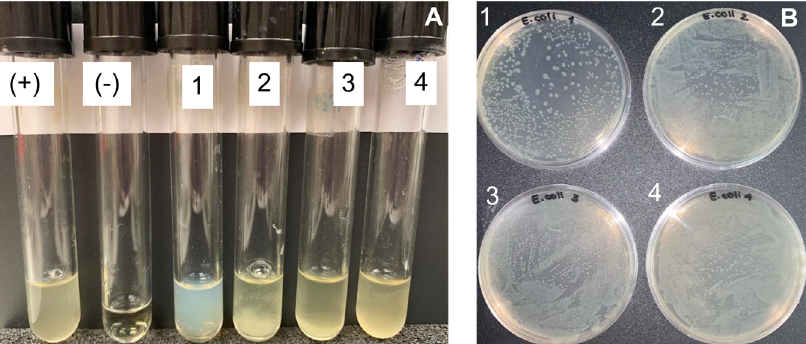
Figure 7. Antimicrobial activity of S. entomon chitosan solution in a broth macrodilution assay against E. coli ( A ). Growth on plates ( B ). Tube 1: 3.34 mg/mL, tube 2: 1.11 mg/mL, tube 3: 0.37 mg/mL and tube 4 to 0.125 mg/mL. Tube (+) is positive control and tube (–) is a negative control. Table 3. Antimicrobial assay for chitosan solutions .